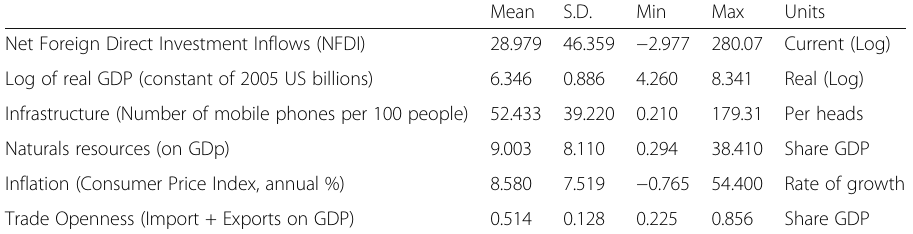
Table 6 Summary Statistics of 9 countries for the period 2001 – 2011: 99 observations